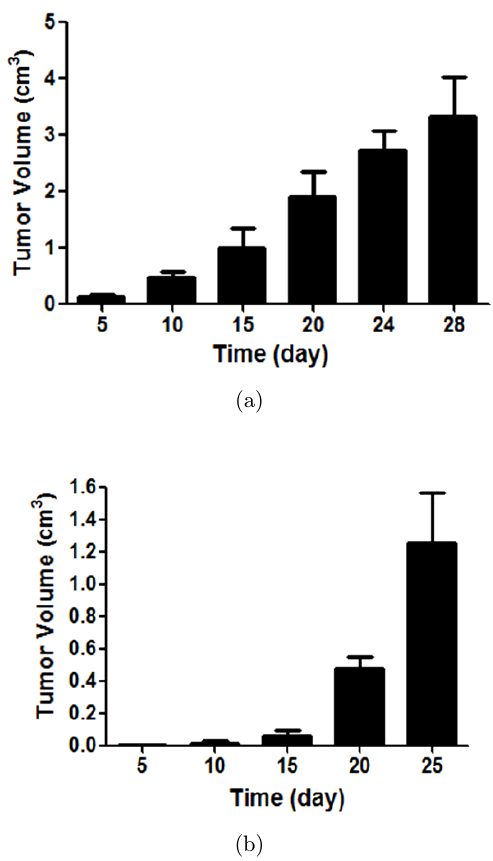
Fig. 7. The tumor volume of s.c. tumor models (a) and orthotopic tumor model (b). n ¼ 10 in each